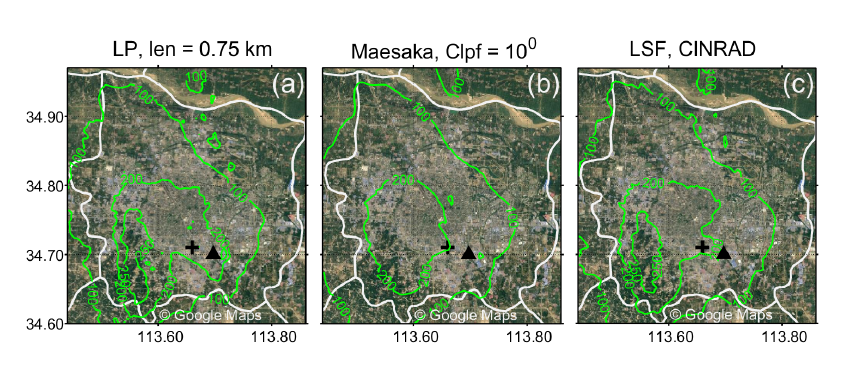
Figure 9. Satellite images from Google Maps overlaid with isolines indicating the rainfall accumulation (mm) during the 14:00–17:00LST period. The rain rate was inferred from R = 51 K 0 . 86 ; K DP was estimated using (a) the LP method with len = 0 . 75km, (b) the Maesaka DP algorithm with Clpf = 10 0 , and (c) the LSF method. The black triangle and cross denote the Zhengzhou radar and the site hosting the gauge with the 201.9mmh − 1 report,